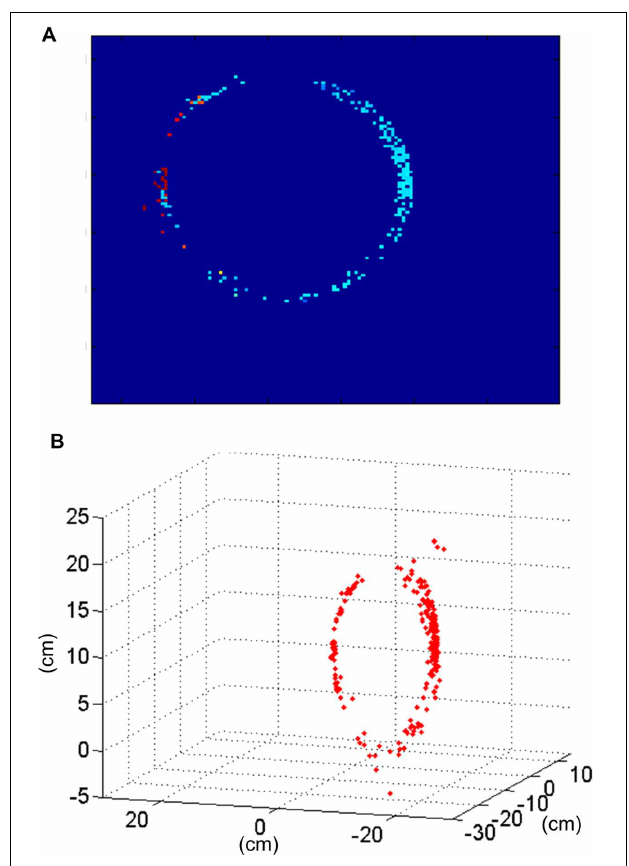
FIGURE 19 | Results obtained for the rotating ring. (A) Disparity map reconstructed with T frame = 50 ms corresponding to the rotation of the ring. (B) Result of the 3D reconstruction of the same frame of the ring